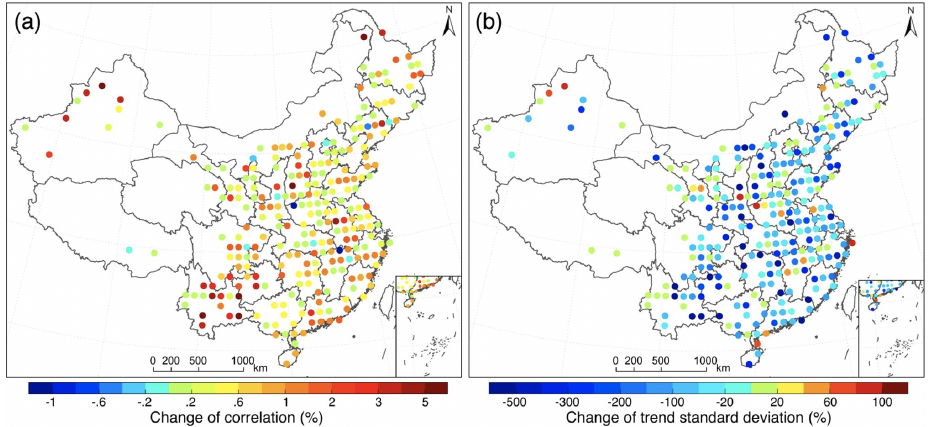
Figure 11. Spatial distributions of (a) the improvements of mean correlation coefficient among PM 2 . 5 concentration records before and after homogenization at a 1 ◦ × 1 ◦ grid cell resolution in the study area, and (b) their corresponding standard deviations of PM 2 . 5 trends.